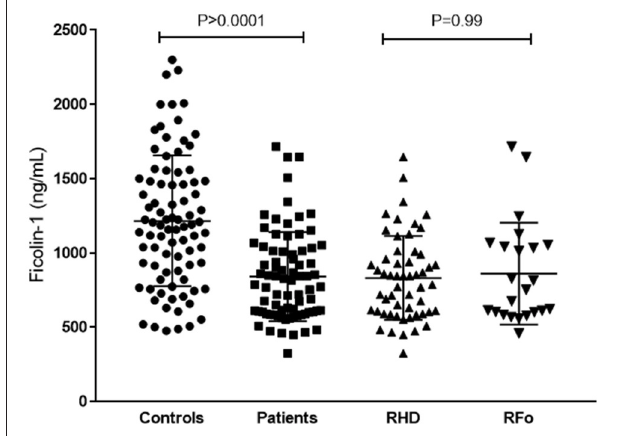
FIGURE 2 | Ficolin-1 serum levels in controls and RF patients. RHD, Rheumatic Heart Disease; RFo, Rheumatic Fever only (not present